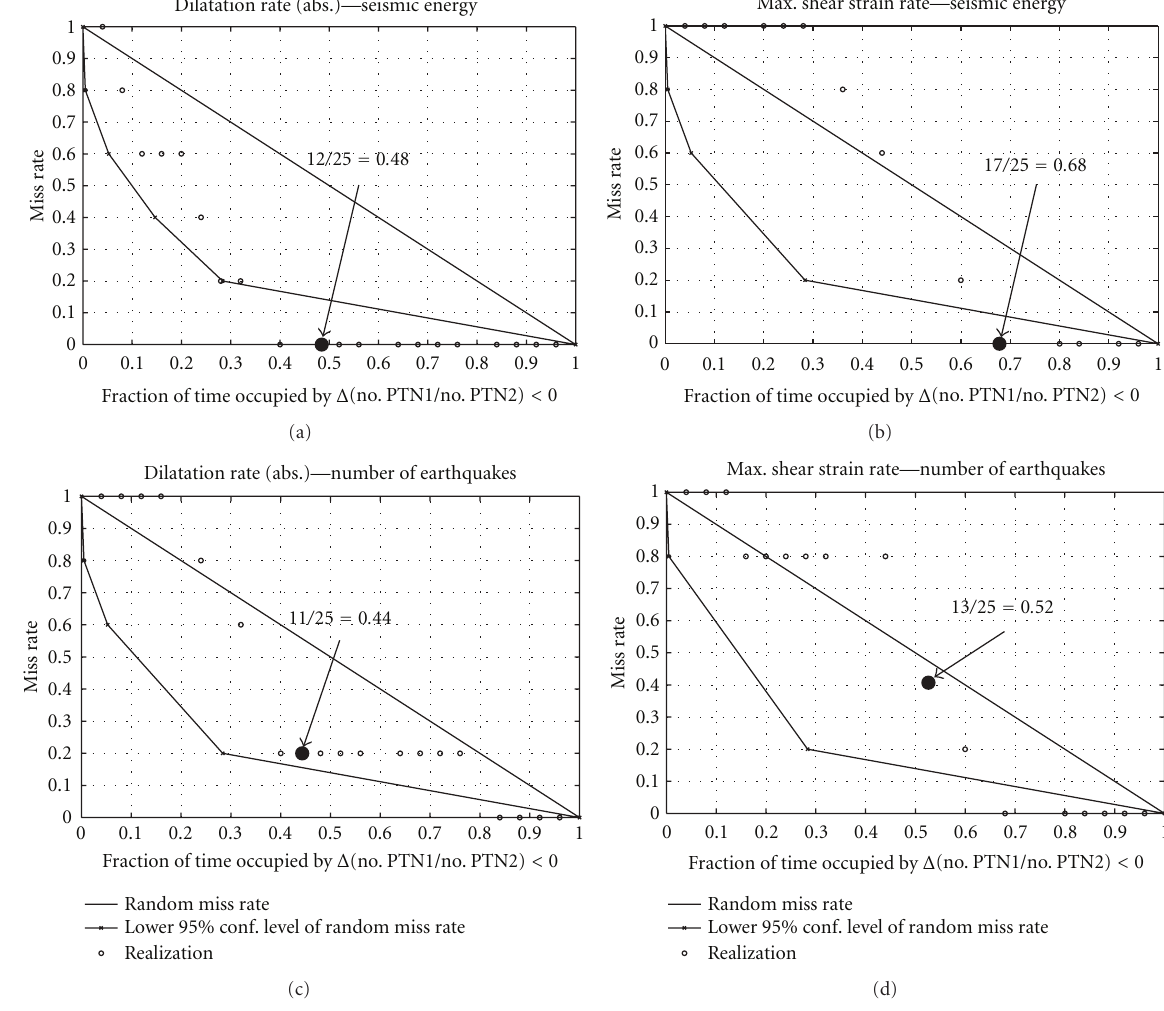
Figure 6: Error diagram (Molchan diagram) for evaluating the significance of the performance of a proposed potential condition for the occurrence of large inland